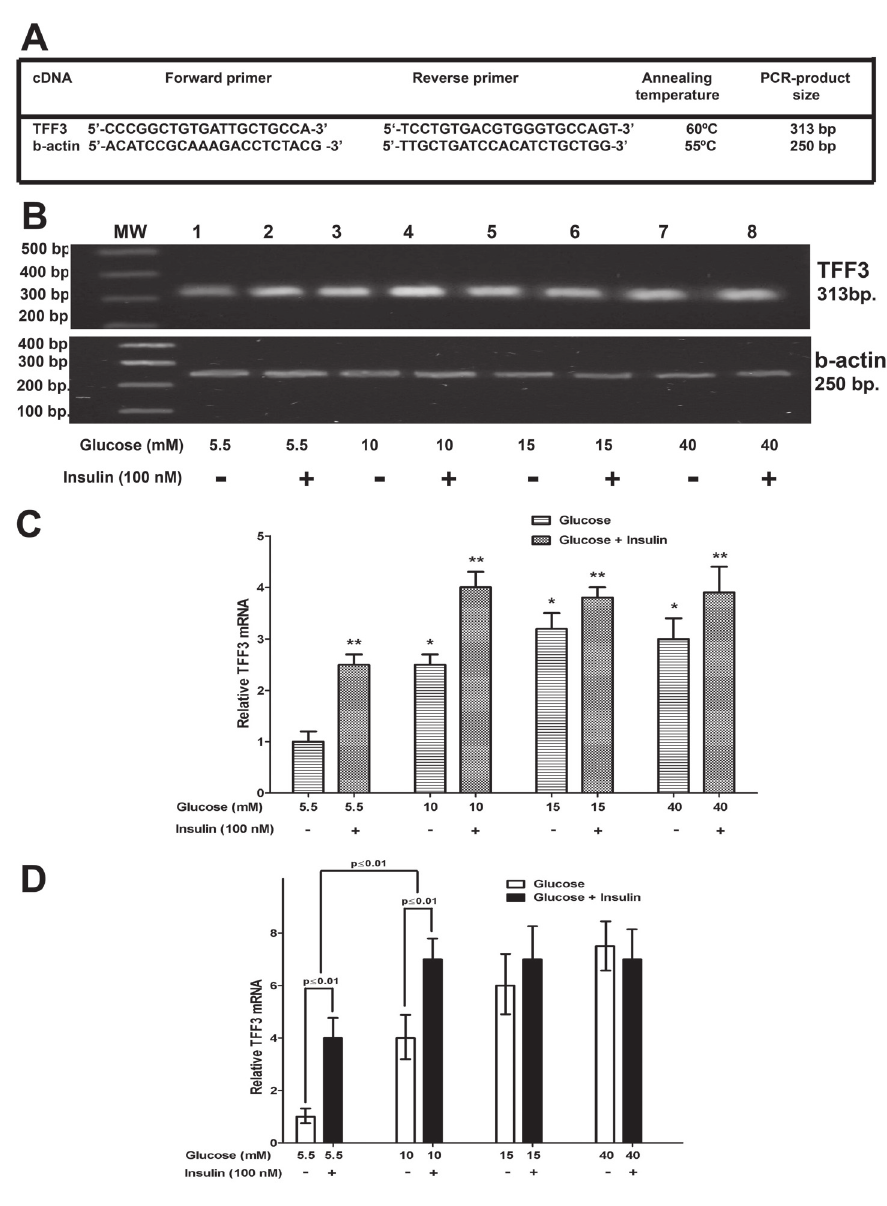
FIGURE 2. Quanti fi cation of differentially-expressed TFF3 mRNA by RT-PCR and RTq-PCR: (A) Speci fi c primers and anneal- ing temperatures employed in semi-quantitative PCR (RT-PCR). (B) RT-PCRs for TFF3 and β -actin were carried out from cell culture samples divided in eight groups: Cells treated with glucose 5.5 mM without and with insulin (100 nM) (lane 1 and 2), cells treated with glucose 10 mM without and with insulin (100 nM) (lane 3 and 4), cells treated with glucose 15 mM without and with insulin (100 nM) (lane 5 and 6), cells treated with glucose 40 mM without and with insulin (100 nM) (lane 7 and 8). The PCR-products were run onto 2% agarose gel electrophoresis. Control reactions without reverse transcriptase were carried out. PCR was performed in a fi nal volume of 25 μ l containing 1 μ l of the reverse transcription reaction, 50 μ M of dNTPs, 1.5mM MgCl2, 50mM Tris–HCl (pH 8.0), 1 IU Taq polymerase and 0.2 μ M each of sense and antisense primers. Speci fi c PCR for a constitutively expressed gene ( β -actin) was carried out as a positive control. The relative amount of product was quanti fi ed by densitometric analysis of DNA bands (C). Trefoil-mRNA expression levels are shown normalized to β -actin. (D) Quantitative Real Time-PCR (RTq-PCR). Results are mean ± SEM of three independent